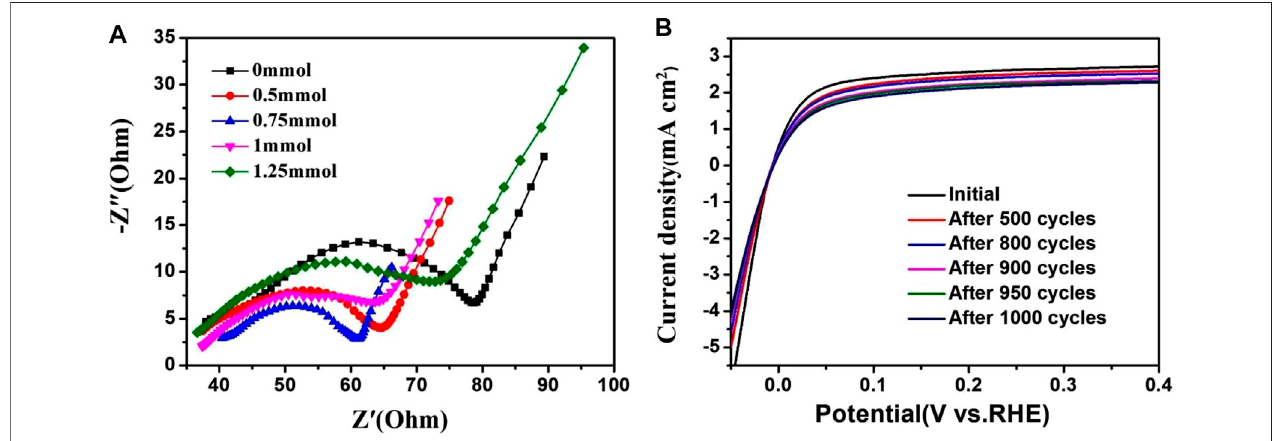
FIGURE 8 | (A) Nyquist plots of PtRu/C catalysts (B) Polarization curves of PtRu/C-0.75 before and after 1000 CV